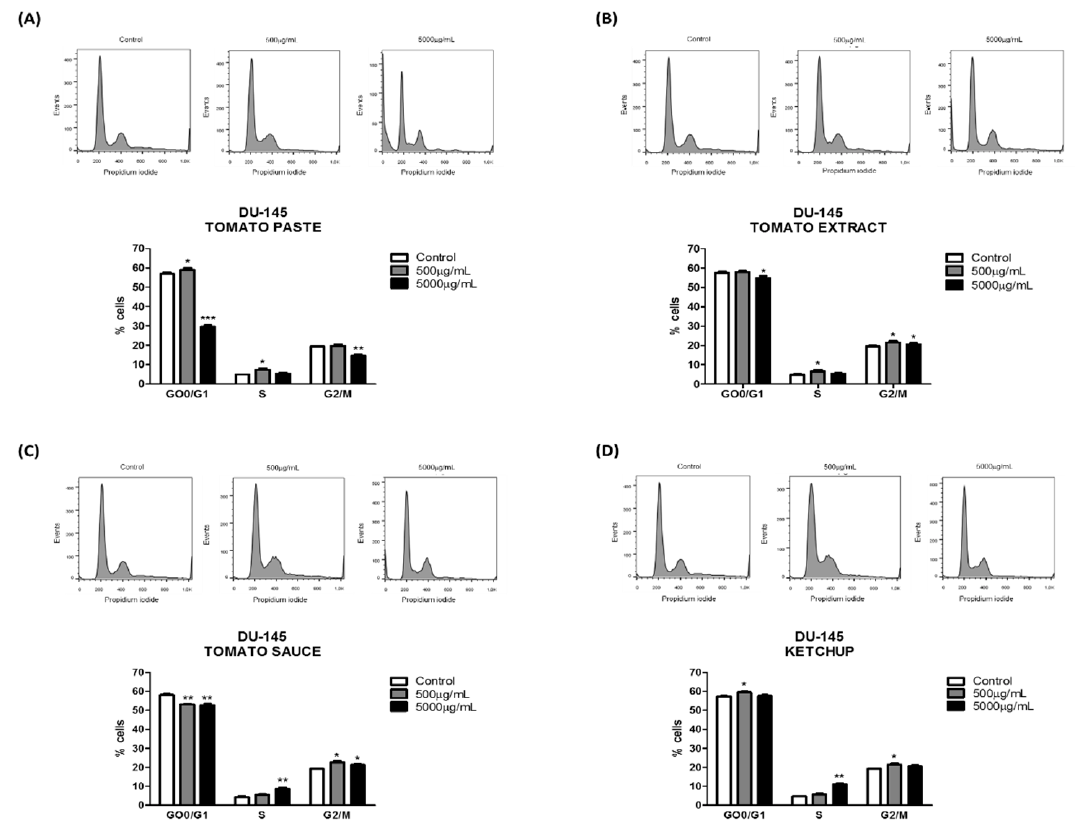
Figure 3. Effect of lycopene obtained from tomato paste ( A ), tomato extract ( B ), tomato sauce ( C ), and ketchup ( D ) on DU-145 cell cycle after 96 h of exposure, respectively. The results are expressed as mean ± error standard and significant differences between untreated cells (Control) and those treated with lycopene (500 and 5000 μ g/mL) were compared by 1-way ANOVA followed by Tukey’s multiple comparison post-hoc test. * p < 0.05; ** p < 0.01; *** p < 0.001.